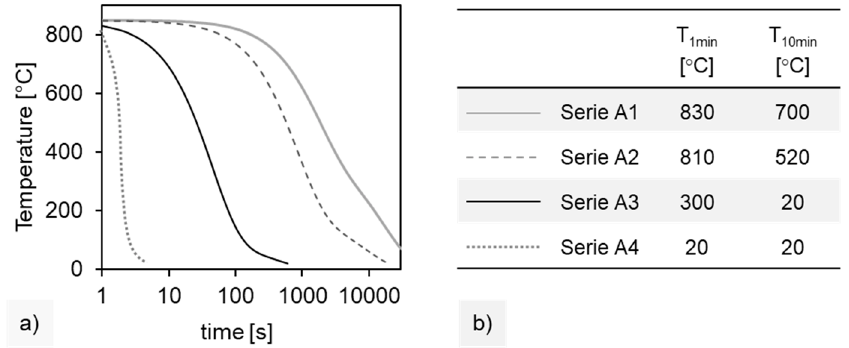
Figure A2. Comparison of fitted temperature-time profiles during the four thermal shock treatments ( a ) graphically, ( b ) by characteristic temperatures after 1- and 10-min cooling. Exemplary optical microscope images of the polished cross-sections of Series from A1 to A4 are given in Figure A3.